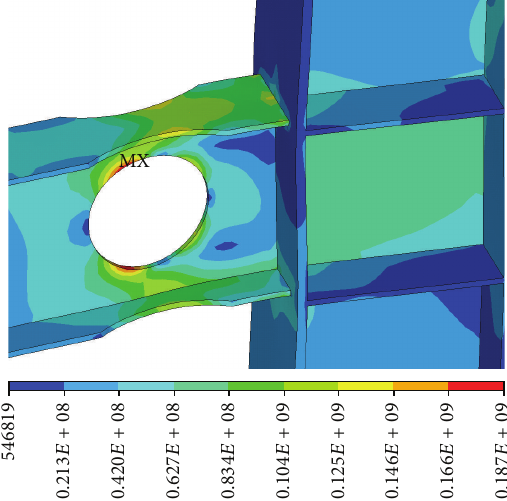
Figure 19: Stress-strain curve of top connection.